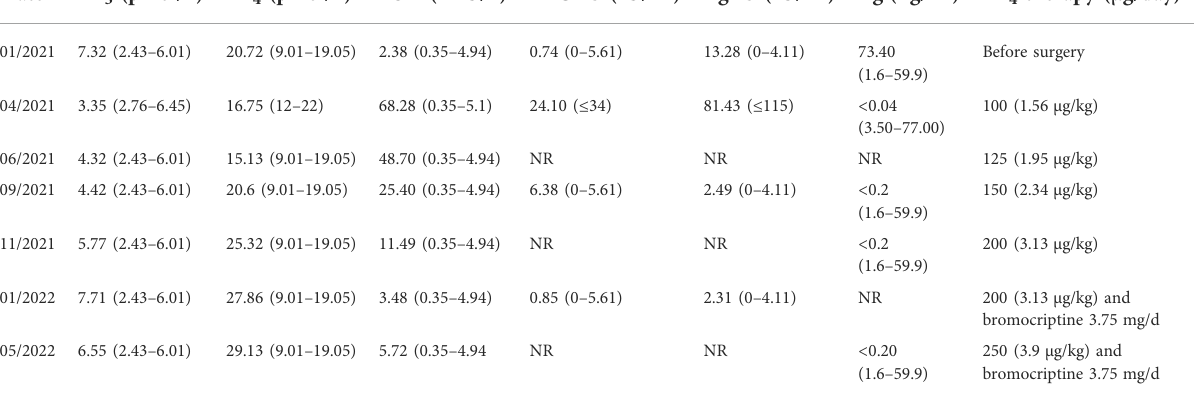
TABLE 1 Thyroid Indicators Measurement During Follow-Up of patient one as Related to Levothyroxine